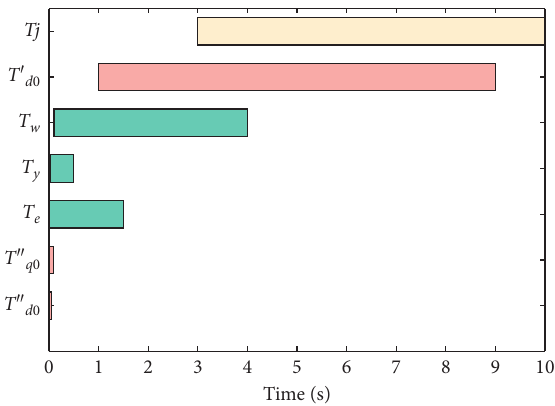
Figure 19: Common ranges of some basic time constants in PSP.